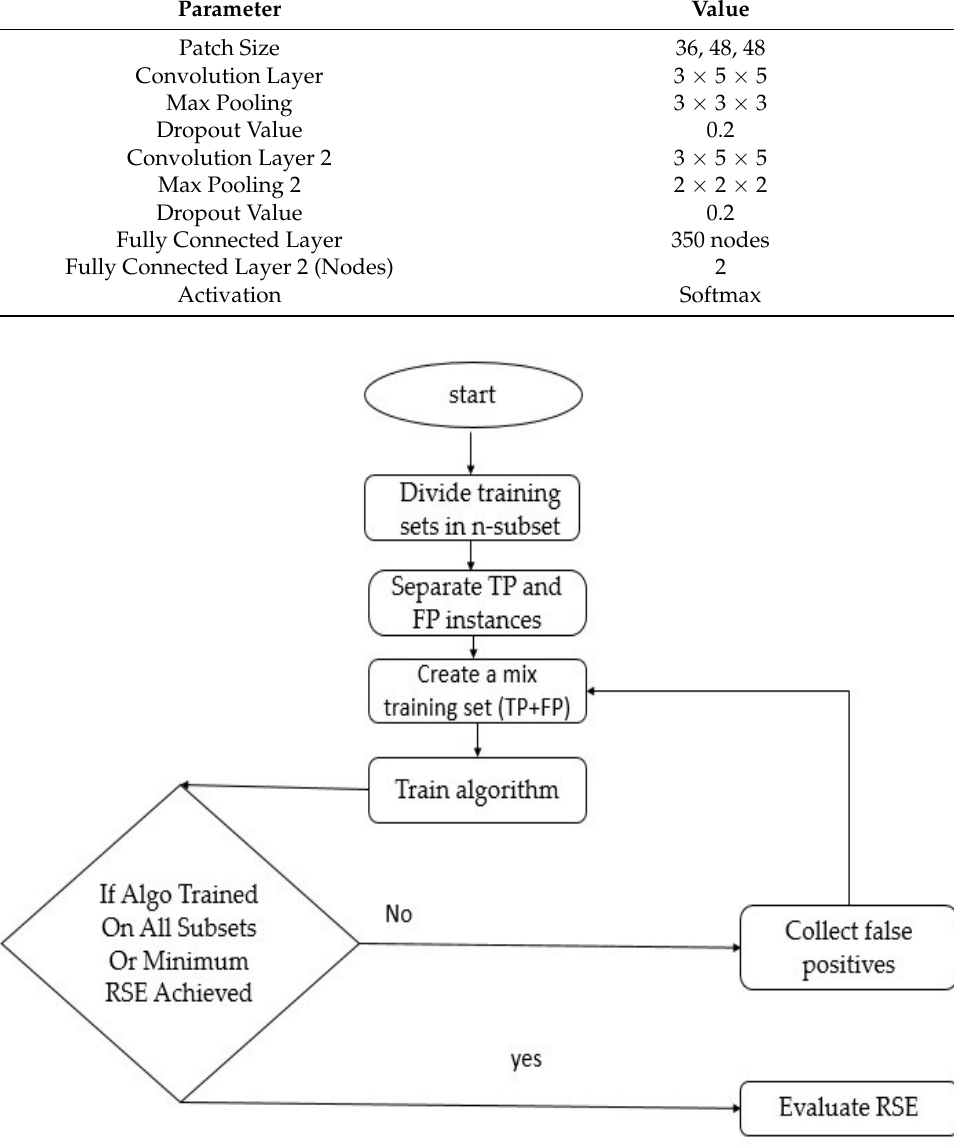
Figure 8. A training algorithm for false positive reduction.